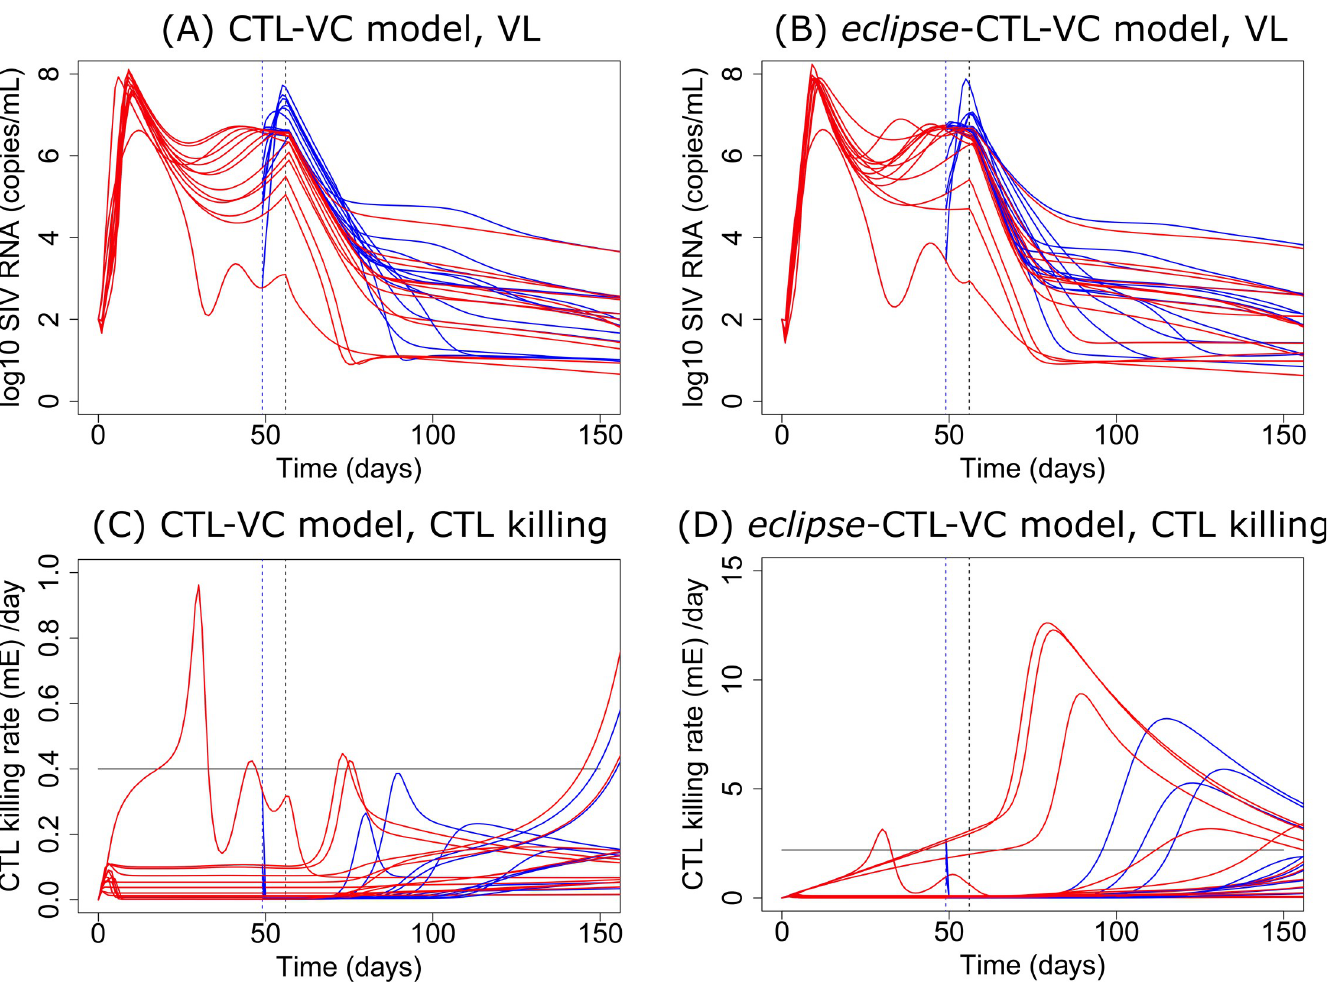
Fig 6. Depleting CD8 T cells one week before ART does not affect the first phase VL decay slope in most RMs due to small CTL killing rates. The first vertical dashed line indicates the time of CD8 depletion, and the second vertical dashed line indicates the start time of ART. Red lines show model predictions without CD8 depletion, and blue lines show predictions when CD8 + lymphocytes are depleted one week before ART. (A) Predicted viral dynamics from the CTL-VC model. (B) Predicted viral dynamics from the eclipse -CTL-VC model. (C) Predicted CTL killing rate ( mE ) from the CTL-VC model. (D) Predicted CTL killing rate ( mE ) from the eclipse -CTL-VC model. Black solid lines in (C) and (D) show the estimated cytopathic cell death rates in both models. See S2 Text for an explanation of why the estimated cytopathic killing rate δ = 2.20 d − 1 is significantly higher than the death rate in the CTL-VC model. Both models showed the same VL decline slopes with or without CD8 depletion before ART, as well as smaller CTL killing rates than the cytopathic cell death rate in most RMs before ART.